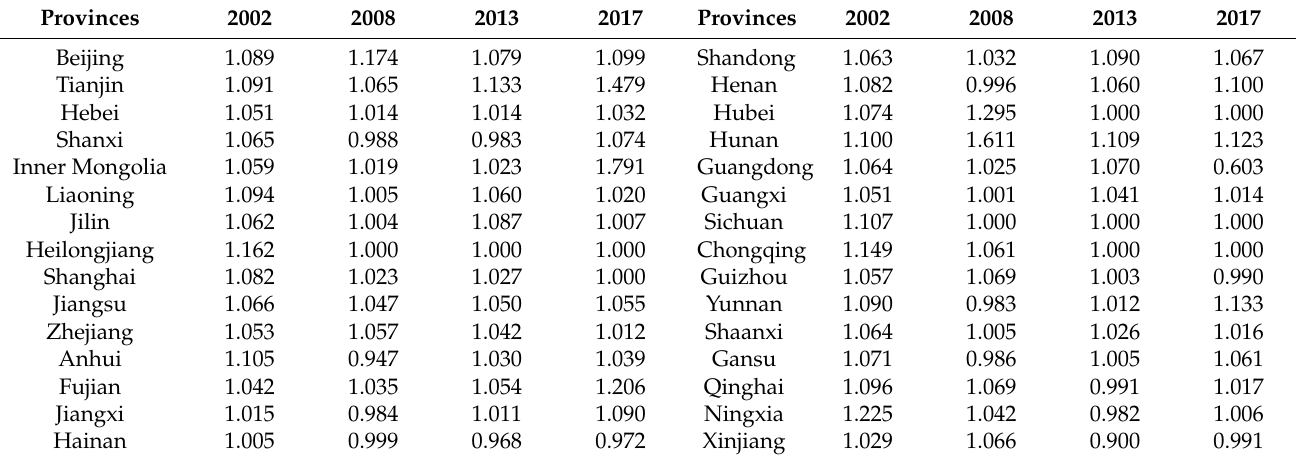
Table 3. Green total factor productivity (GTFP) of provinces in China in some major